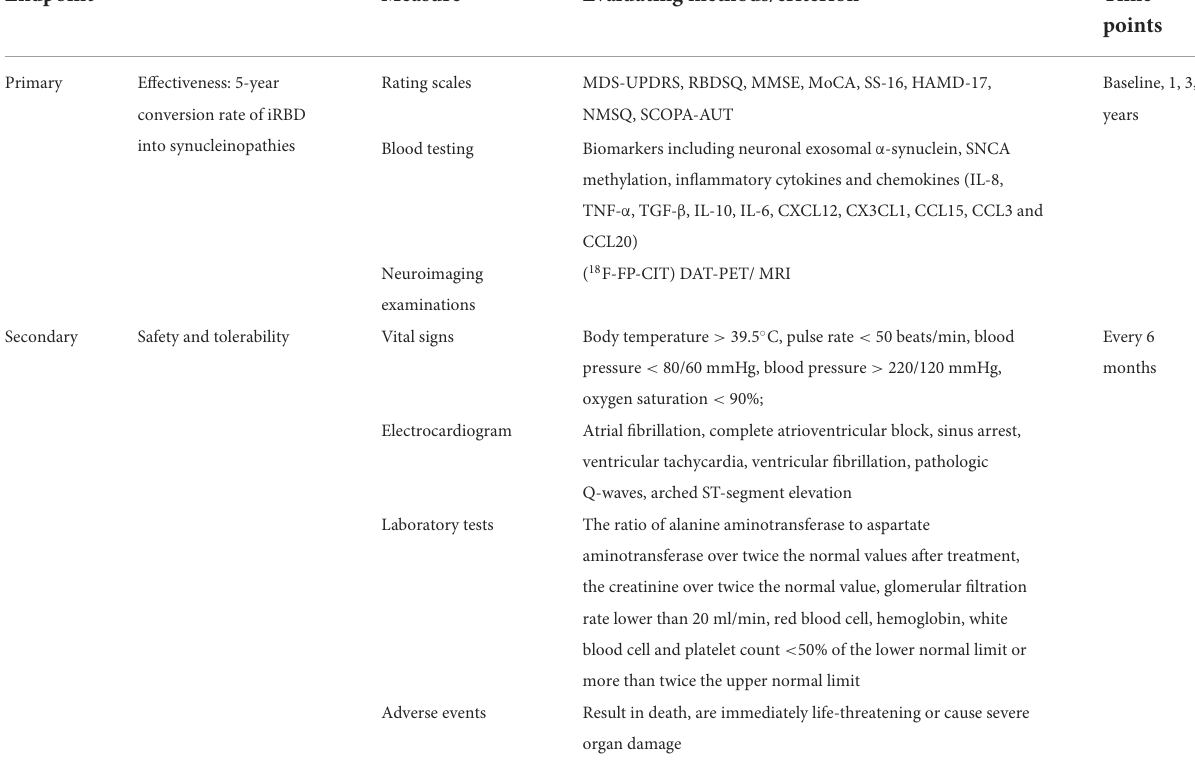
TABLE 1 Outcome measures taken at baseline and